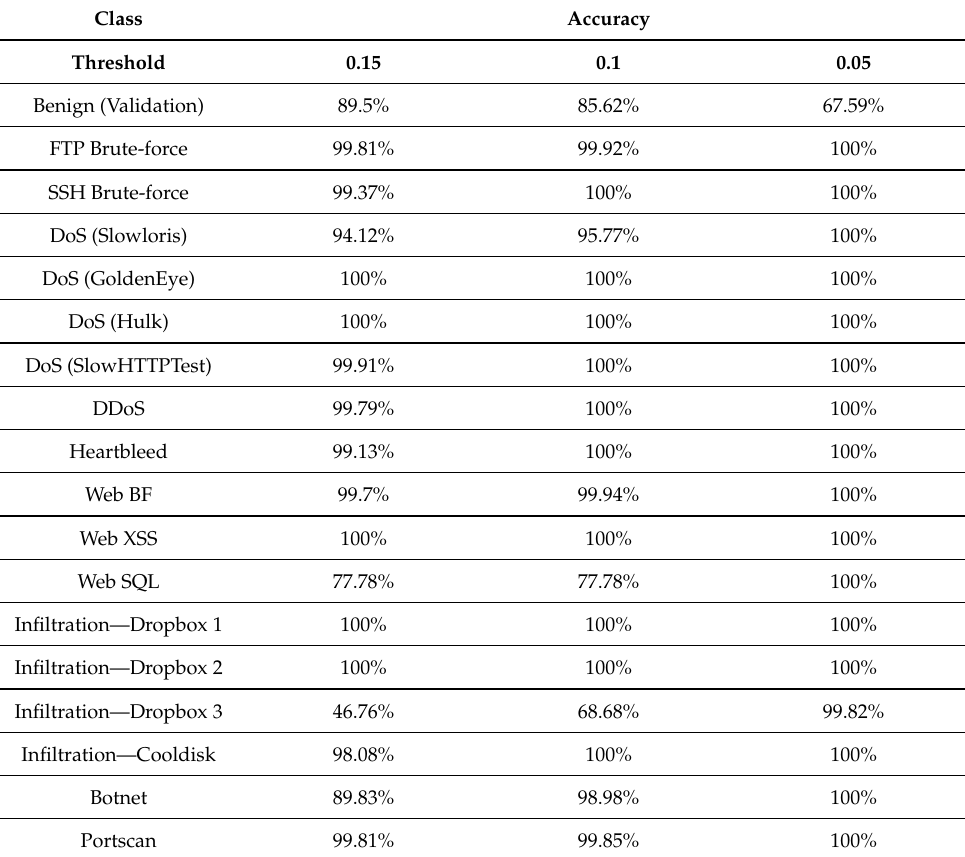
Table 13. CICIDS2017 autoencoder zero-day detection results using flow aggregation